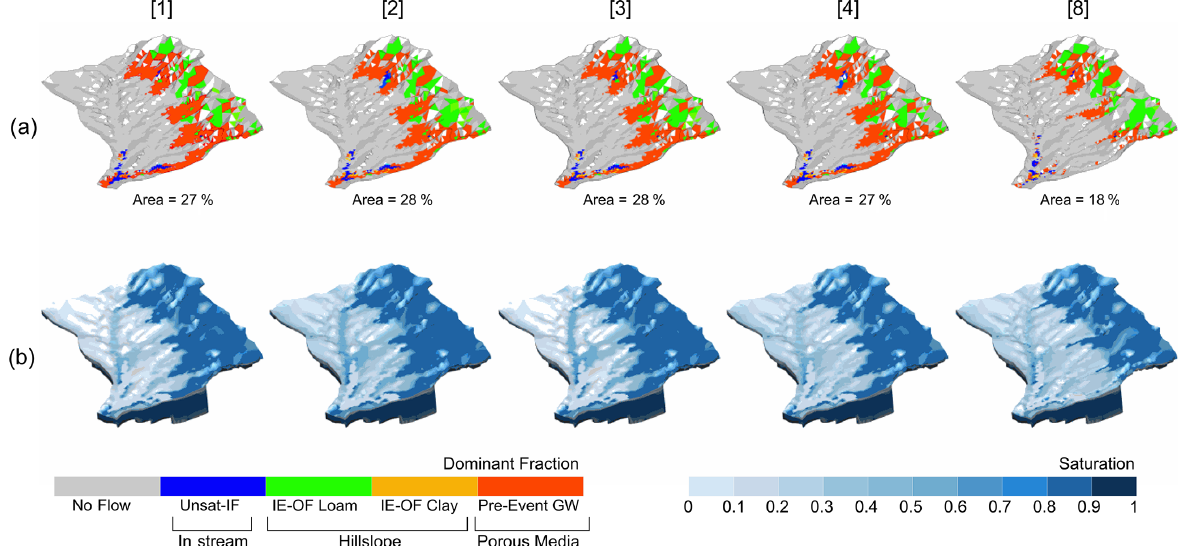
Figure 5. Snapshots of time step 960 during a rainfall event showing (a) the spatial extent of active areas by their dominant HMC component (flow generation mechanism) for each scenario (1–4 and 8) and (b) the porous media saturation. The spatial extent of active areas as a percentage of the catchment area is shown below the snapshots. Colours for the HMC components show both the dominant process and the origin of the water contributing to the flow in each cell. For example, all red areas are from pre-event GW, some of which can contribute to active areas in both the stream and in the stream